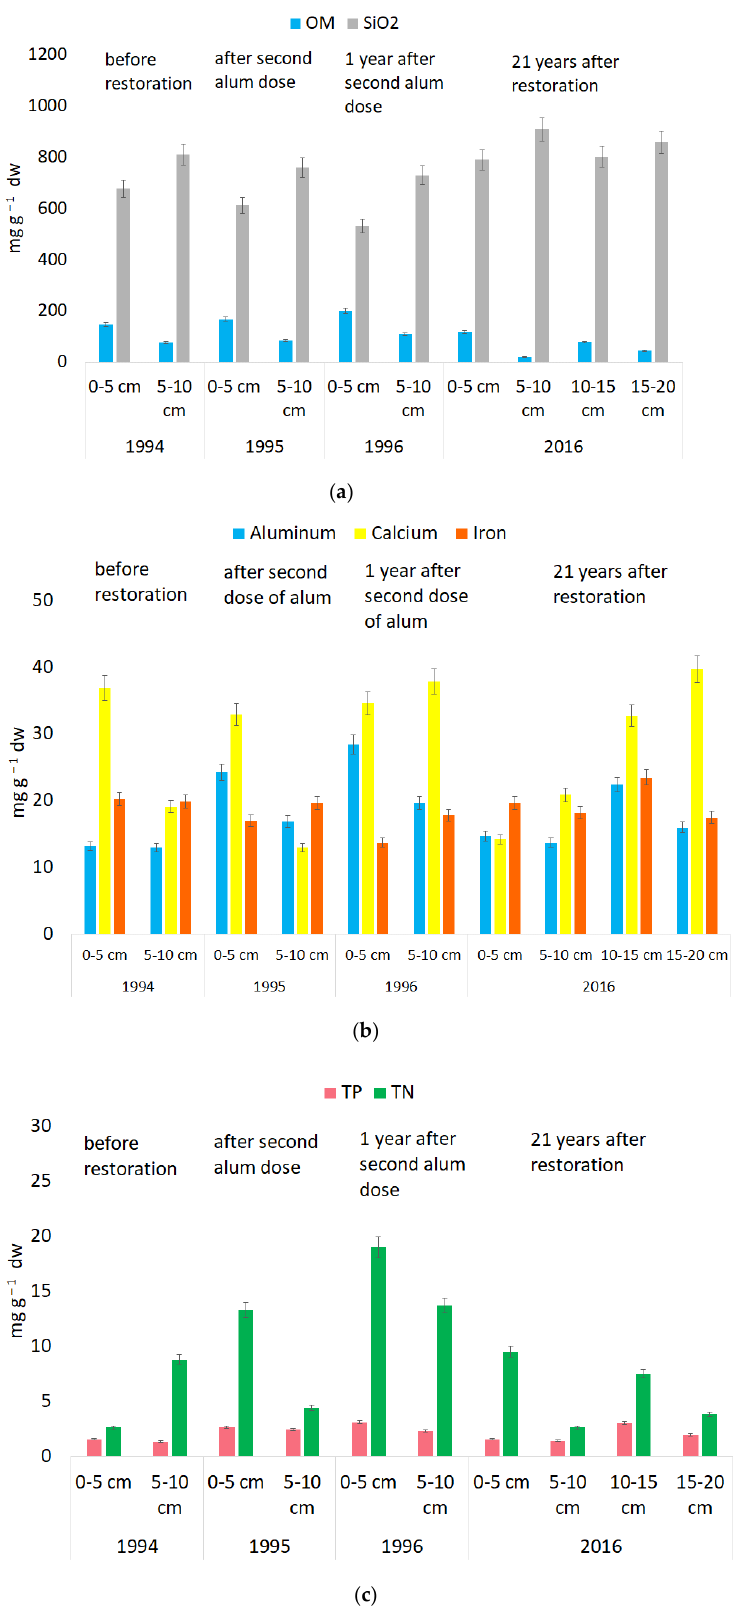
Figure 2. The content (mean values ± SD) of selected components of the bottom sediment of Starodworskie Lake in 1994, 1995, 1996 and 2016: ( a ) Organic matter and silica content; ( b ) aluminum, iron and calcium content; ( c ) nitrogen and phosphorus content.